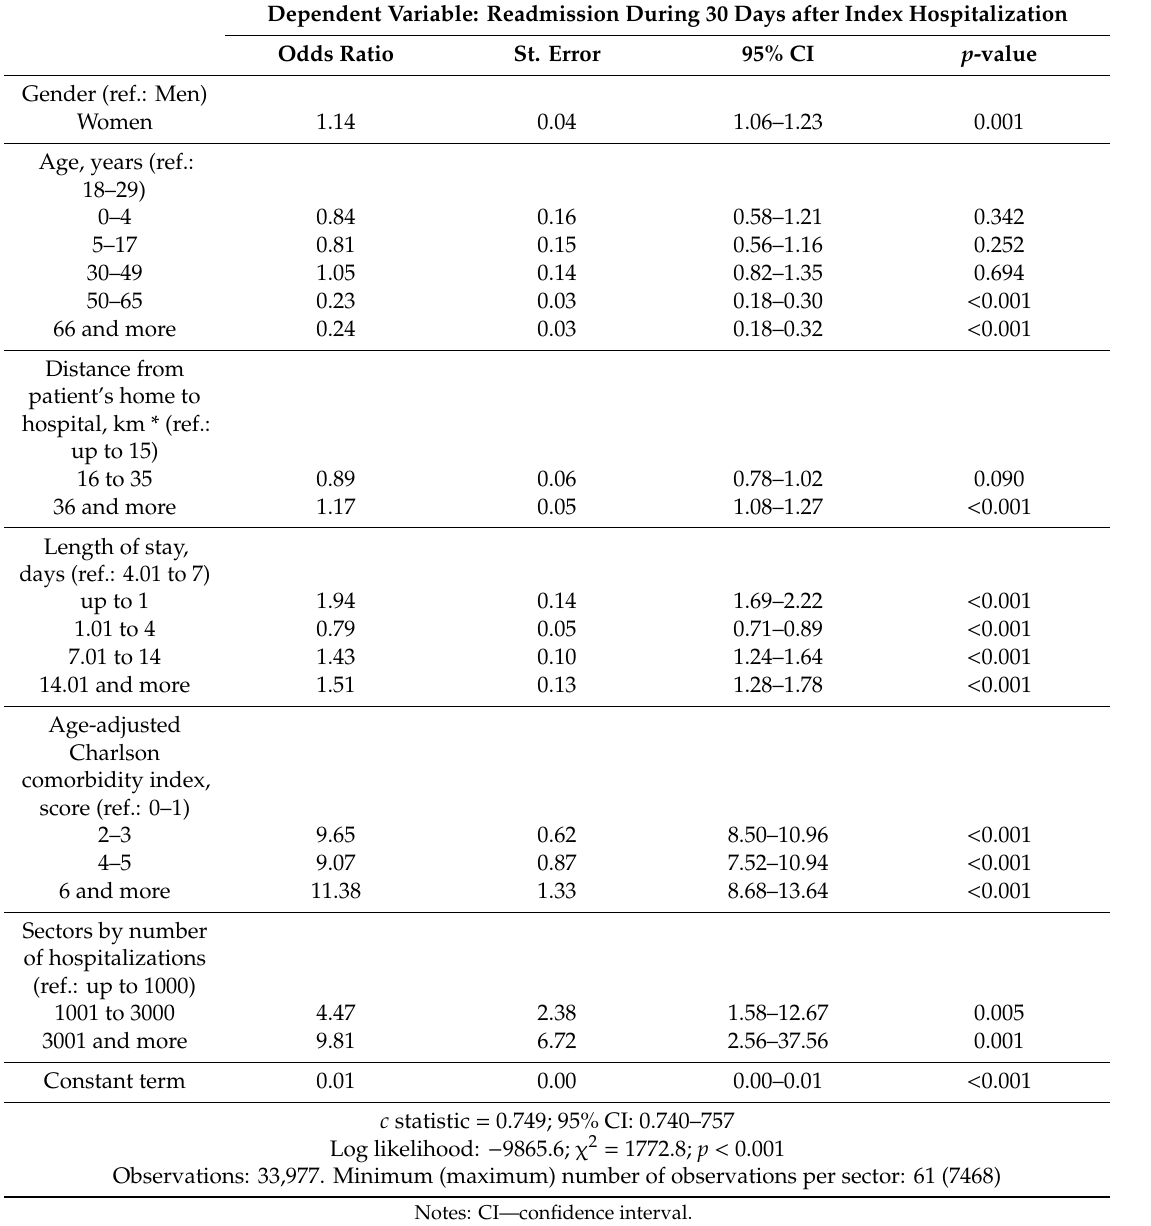
Table 4. Logistic regression estimates for determinants of